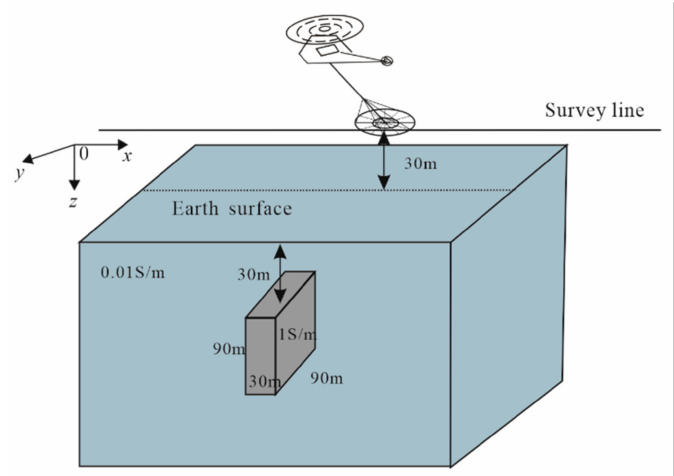
Figure 7. A vertical dyke embedded in a homogeneous half-space.